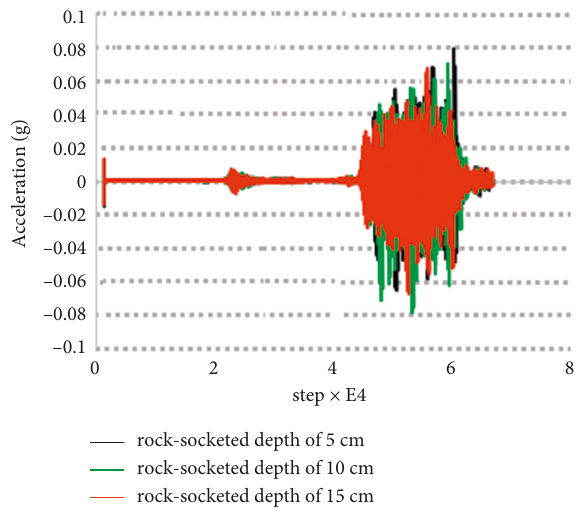
Figure 9: Acceleration-time curves of anchored piles under dif- ferent rock-socketed depths.